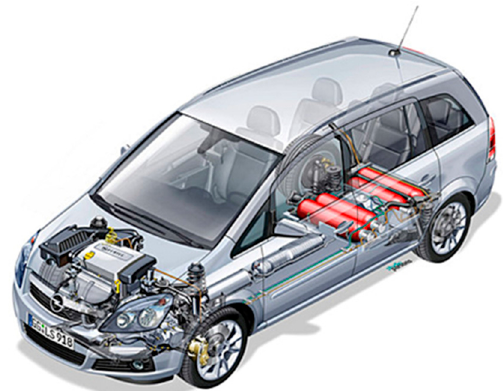
Figure 9. Commercial methane-fuelled vehicle (tanks in red).